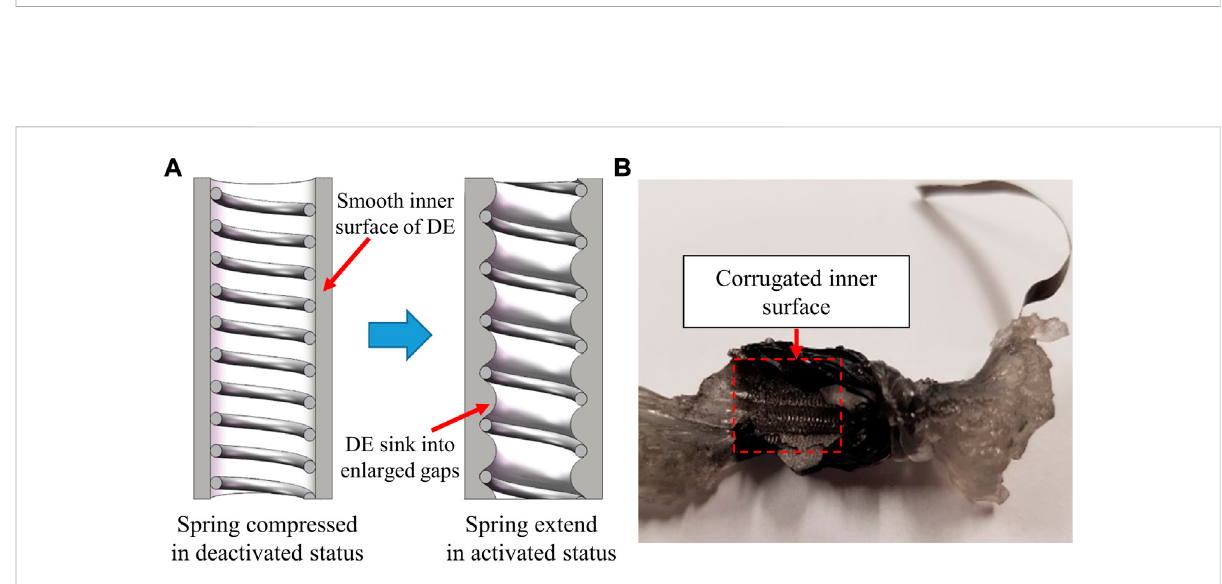
FIGURE 12 Inner surface variation of the spring-roll DE actuator: (A) Spring variation during the activation of the spring-roll DE actuator; (B) Corrugation of the surface of inner layers of the DE actuator.